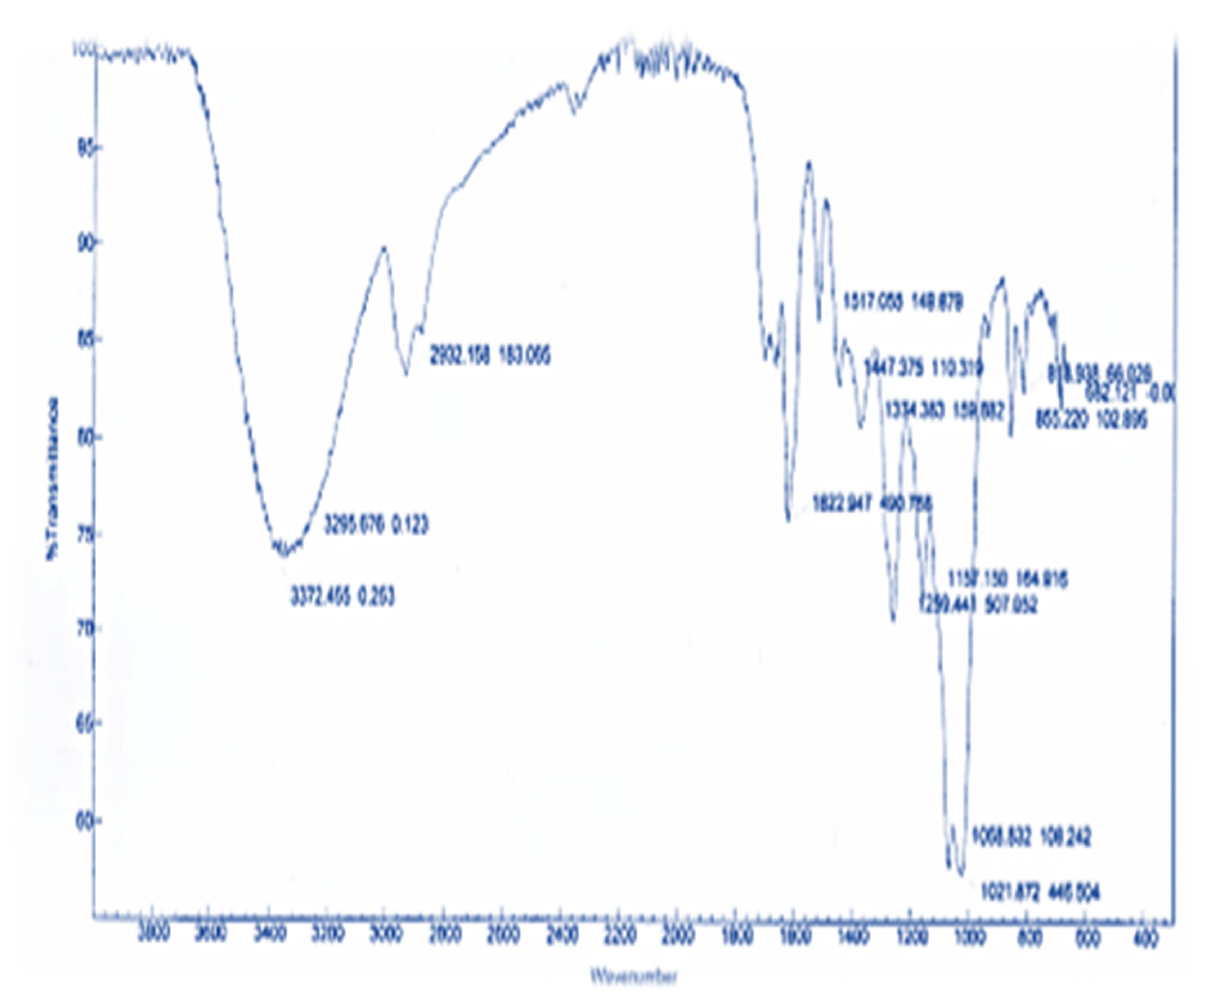
Figure 3. Fourier transform infrared spectroscopy for the isolated component A3.